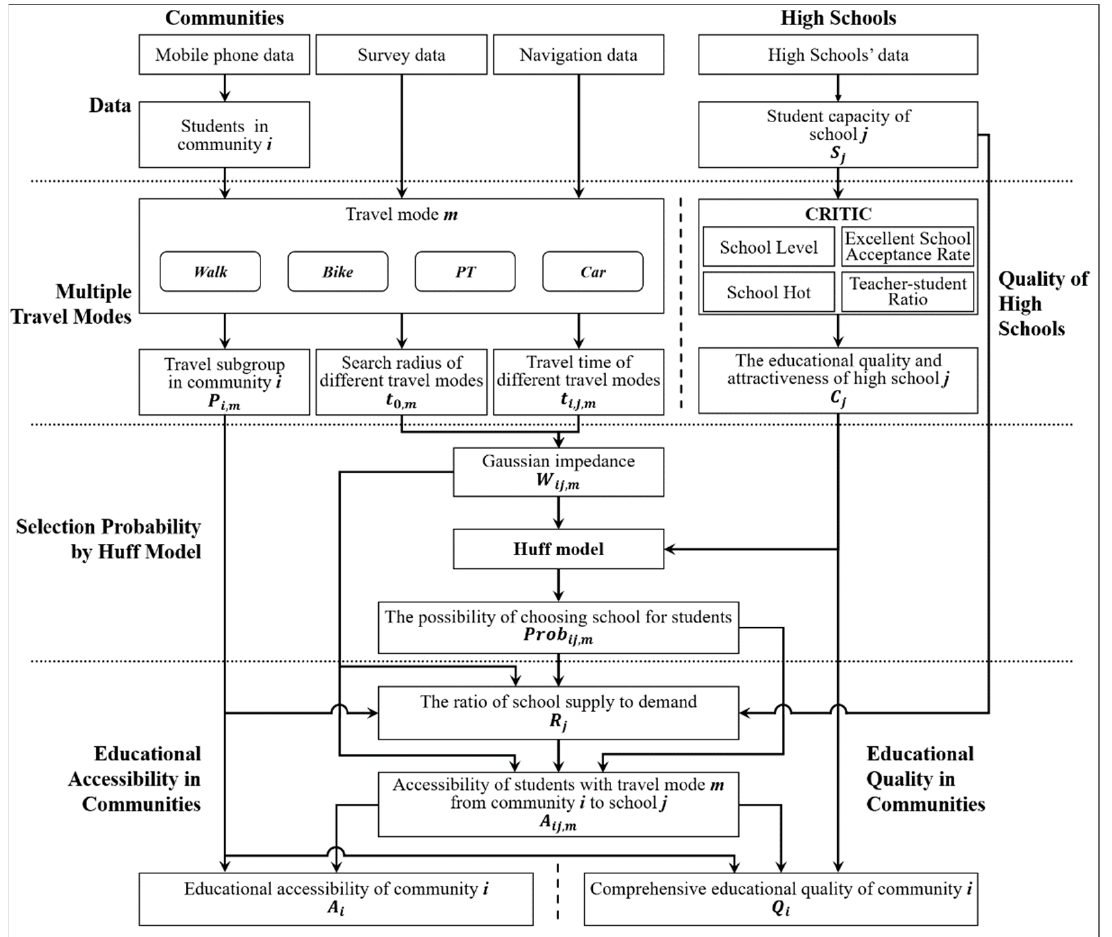
Figure 1. The proposed method to calculate educational accessibility and quality.